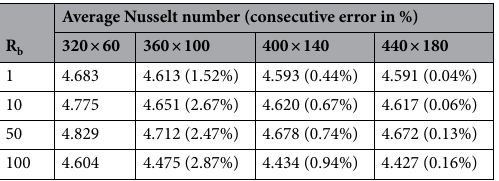
Table 5. Grid sensitiveness with R b = 0 to 100, Le = 1, Pe = 1, χ = 1, Re = 100, Gr = 10 4 , Da = 10 –3 , ε = 0.8, ϕ = 2%, Ha = 30, m = 1, δ = 0.3 and γ = 60°.